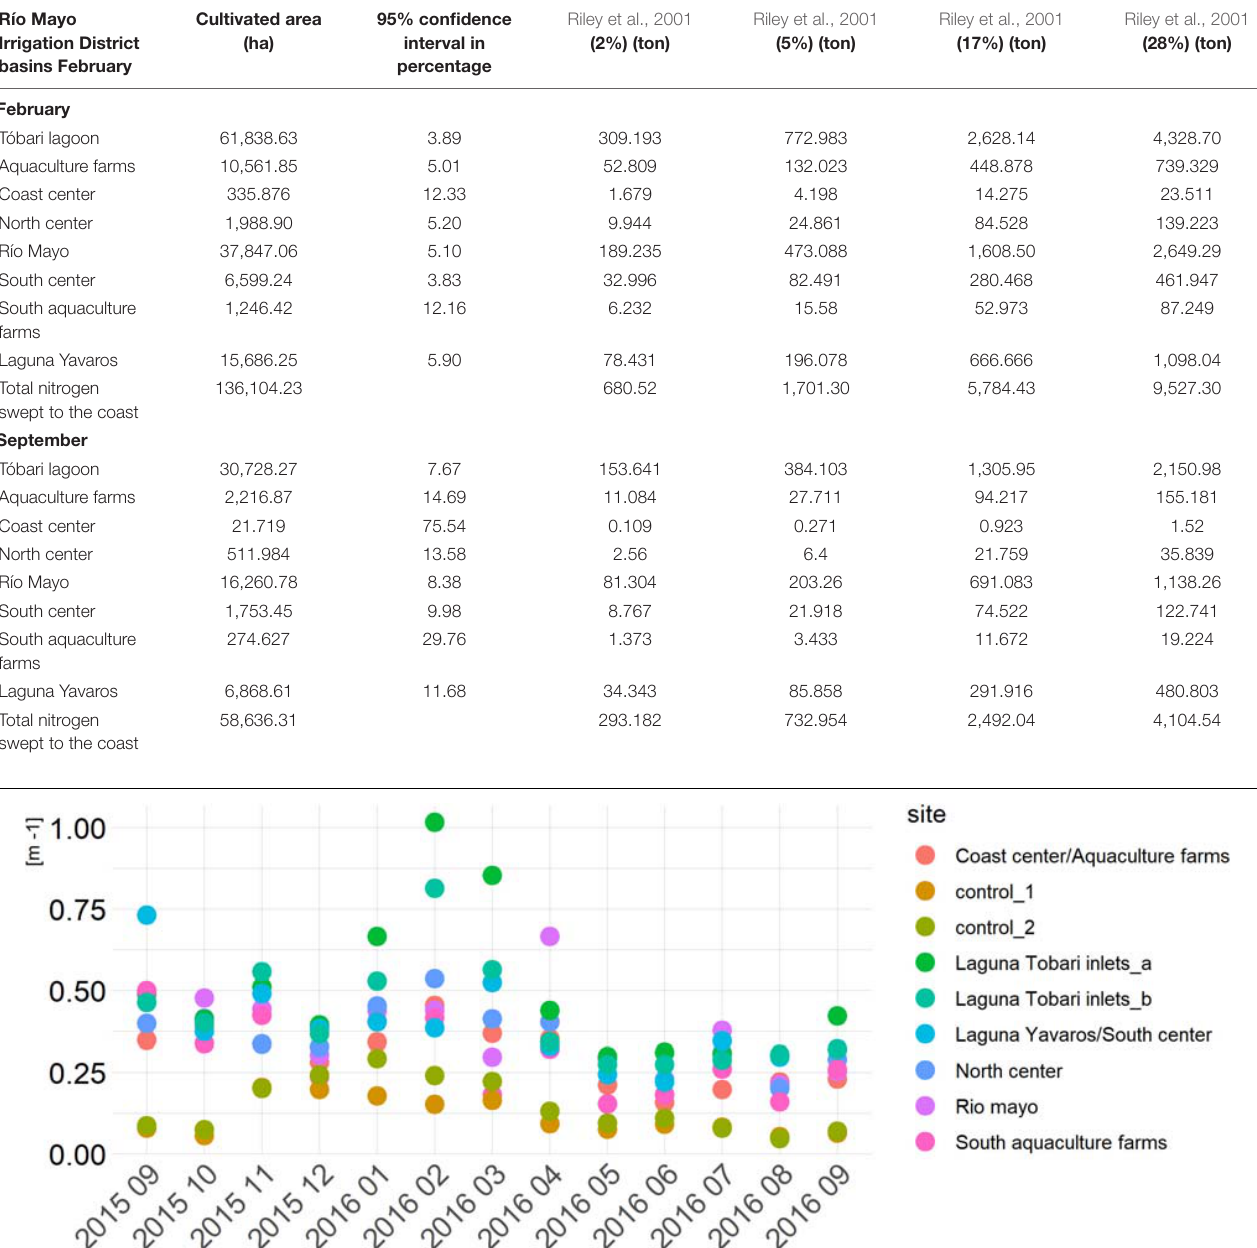
TABLE 3 | Estimate of nitrogen from runoff according to the average used in the literature of 250 kg/ha, as well as estimates of sweep percentage according to the cited literature.